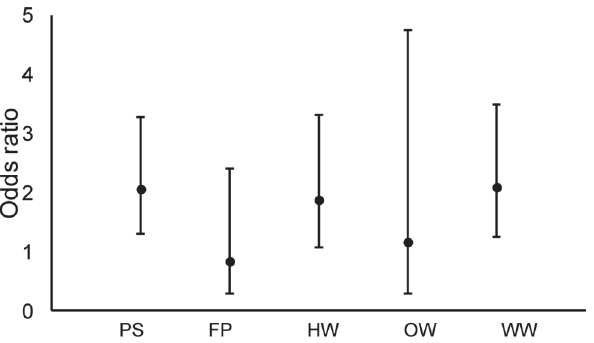
Fig 2. Odds ratios by cover type for eastern diamondback rattlesnake habitat selection at the within- home range scale in the South Carolina Coastal Plain tidewater region. Reference = forest; PS = pine savanna, FP = wildlife food plot, HW = herbaceous wetland, OW = open water, WW = woody